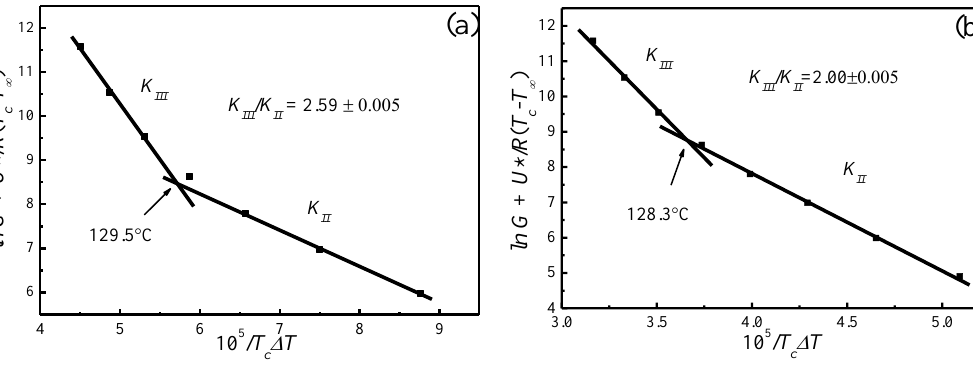
Figure 9. LH plots for ( a ) 𝑇 m0 = 172.8 ° C and ( b ) 𝑇 m0 = 196.4 °C , U* = 1500 cal·mol −1 , and T ∞ = T g − 30 K.